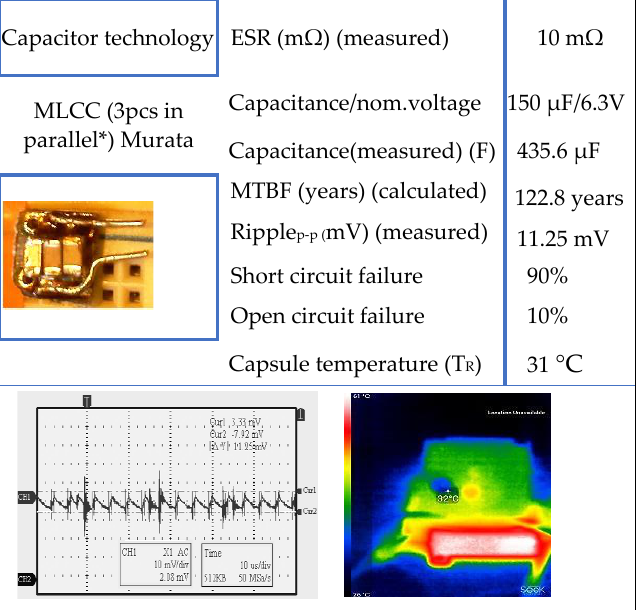
Figure 8. Data taken from measurement, photo of capacitor Ta-MnO 2 type AVX 330G T2601 as DUT (left –center), the actual ripple’s waveform (left) and surface capacitor’s temperature which is re- quired in reliability calculations (right).